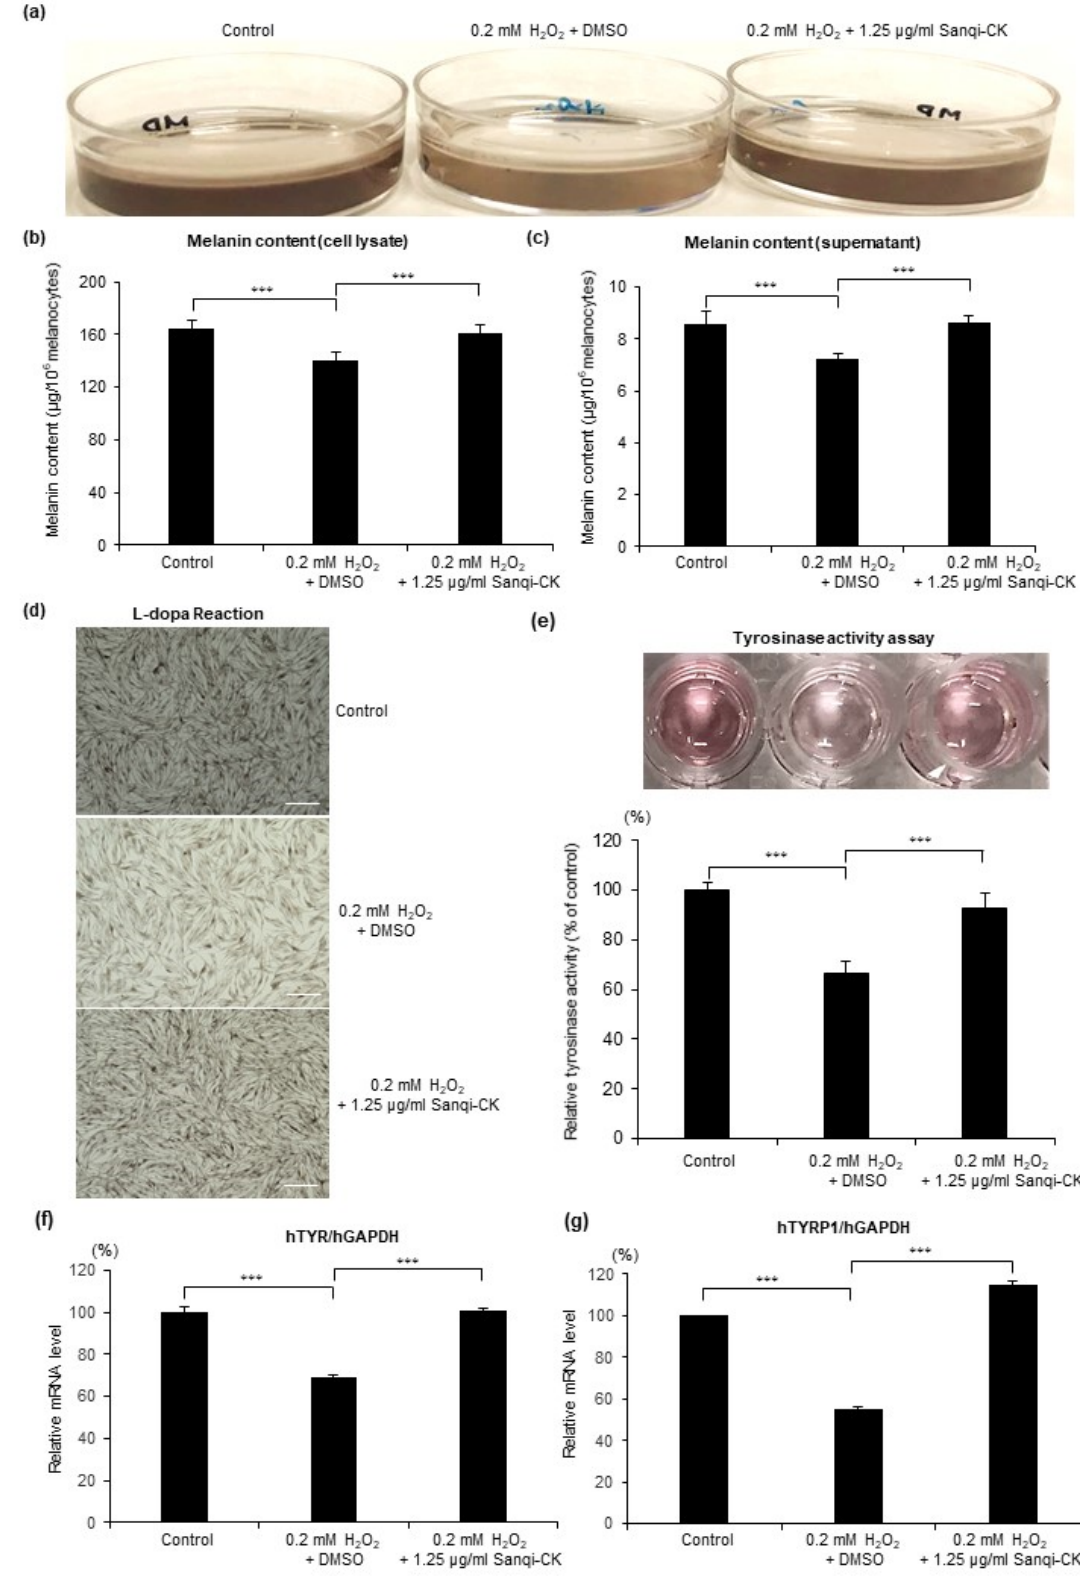
Figure 3. Protective effects of Sanqi-CK on melanin synthesis of cultured HEMn-MPs against H 2 O 2 treatment. Melanocytes were pretreated with a nontoxic concentration of Sanqi-CK (1.25 μ g/mL) for 6 h and then exposed to 0.2 mM H 2 O 2 for 5 days. At the end of these treatments, ( a ) cultured melanocytes in medium were photographed; melanin content was quantified by melanin content assay in ( b ) cell lysates and ( c ) the culture medium; and ( d ) the L-dopa reaction was performed, with changes in pigmentation observed under bright-field microscopy. White bar in ( d ), 50 μ m. At 24 h after exposure to